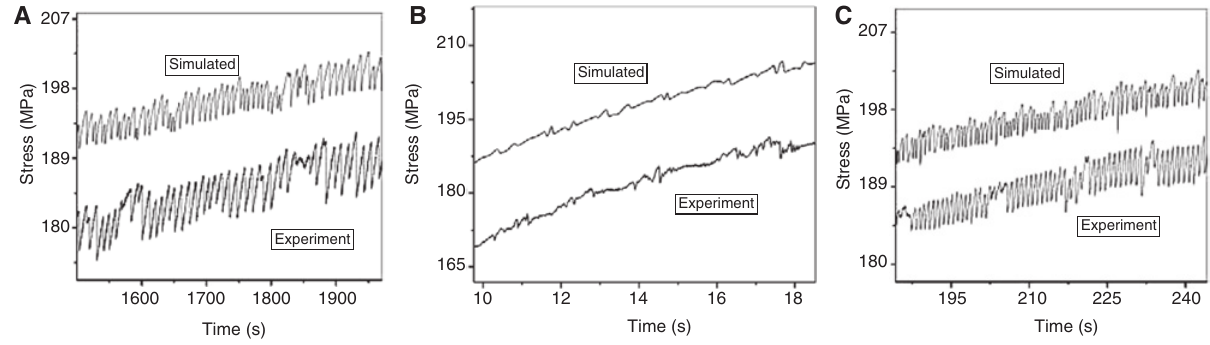
Figure 5: Experimental and simulated observation of three PLC types in tensile test at different applied strain rates.